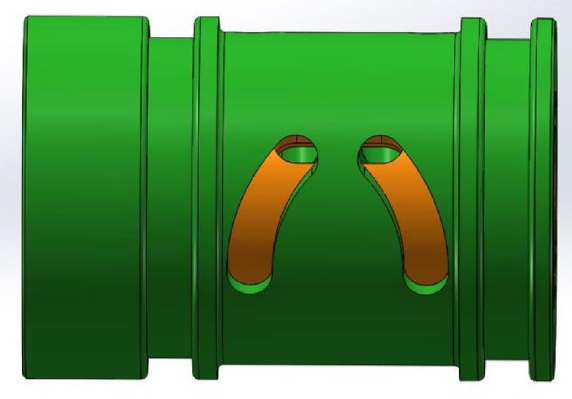
Figure 3. Combination structure of valve sleeve and valve core.